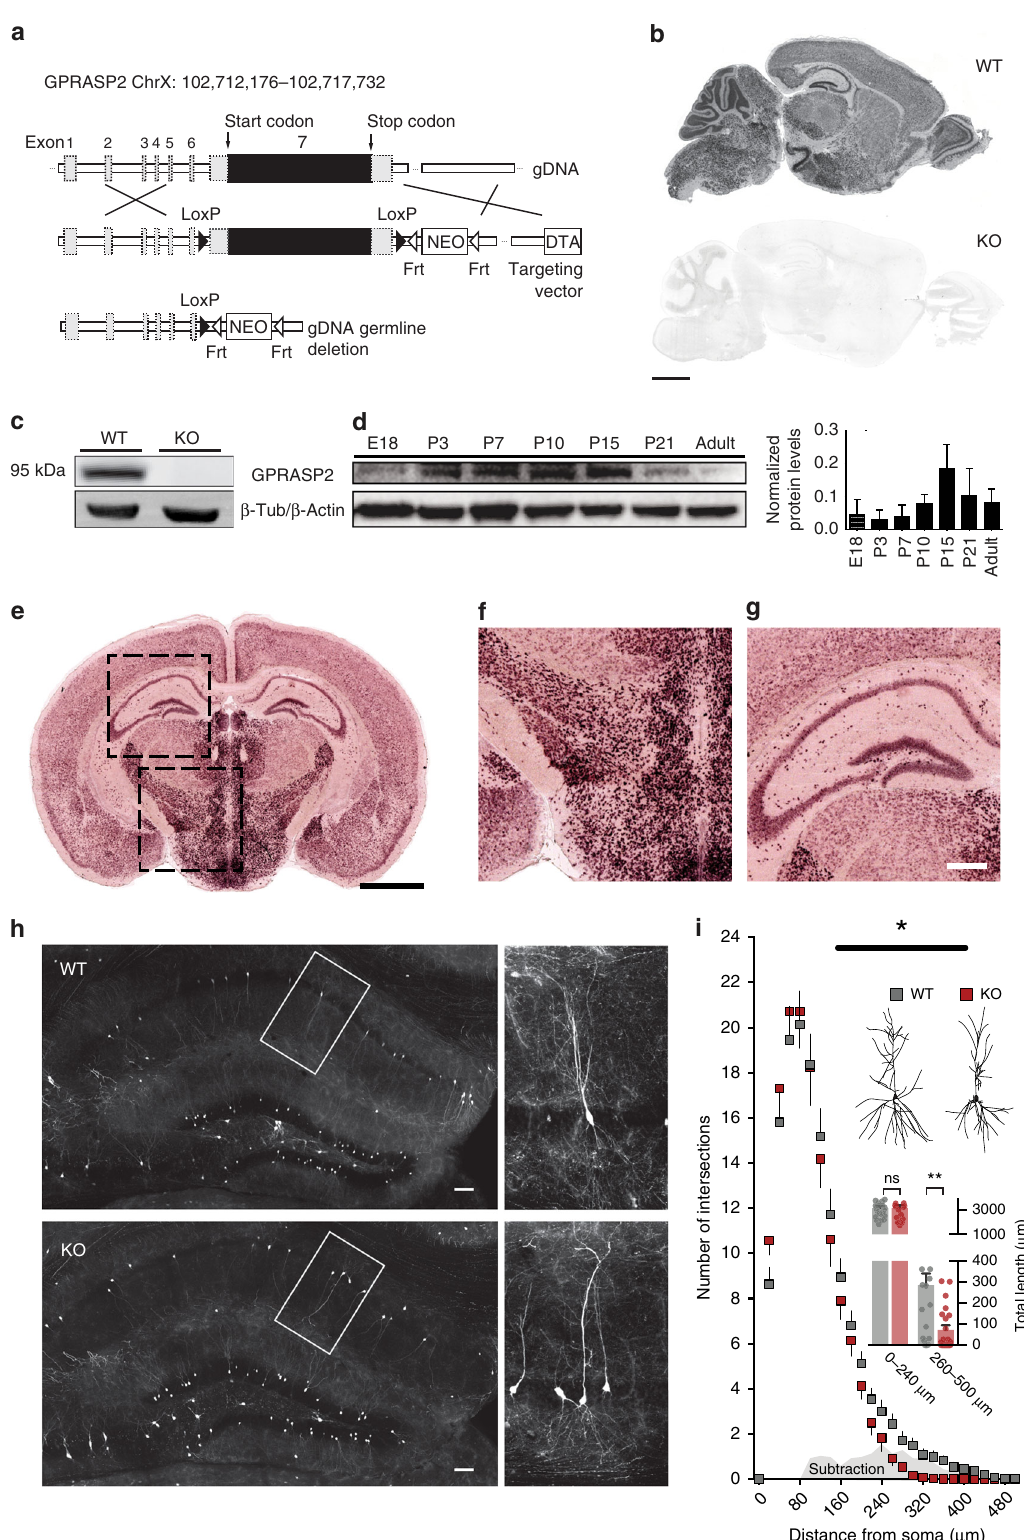
Gprasp2 deletion impairs neuronal spine maturation . To understand if Gprasp2 is required for neuronal spine maturation in vivo, we analysed spine density in GFP-labelled CA1 pyramidal neurons (Fig. 3a). While no signi fi cant alterations in overall spine density counts in apical dendrites were identi fi ed (Fig. 3b), a breakdown of spine categories in mature and immature types